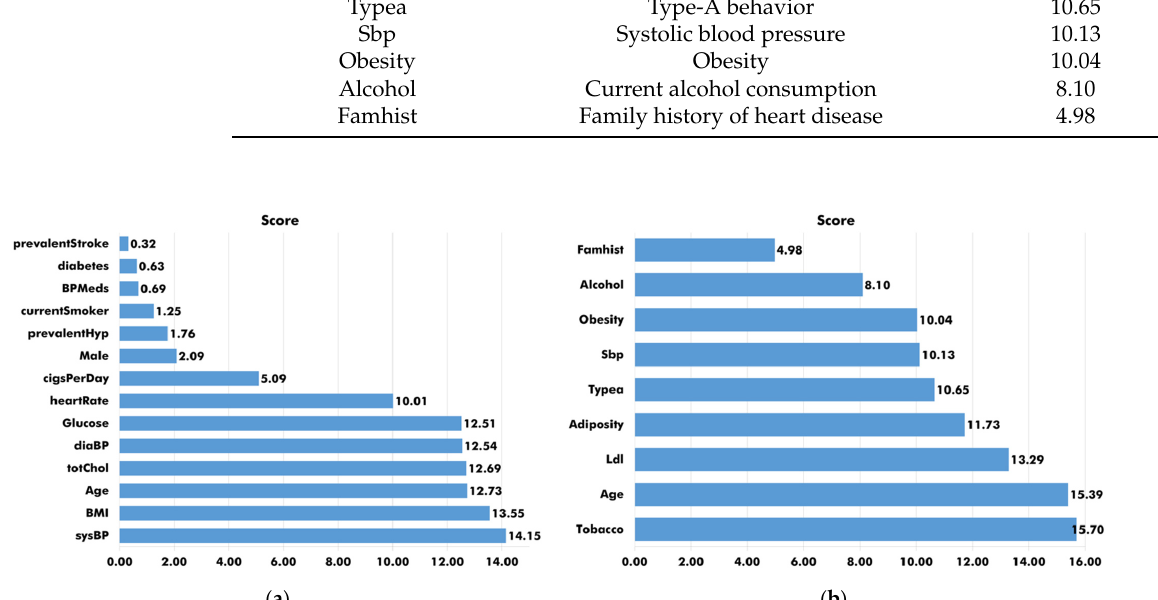
Figure 3. Ranking of attributes selected by Random Forest for CVD prediction on ( a ) Framingham dataset and ( b ) South African Hearth dataset.